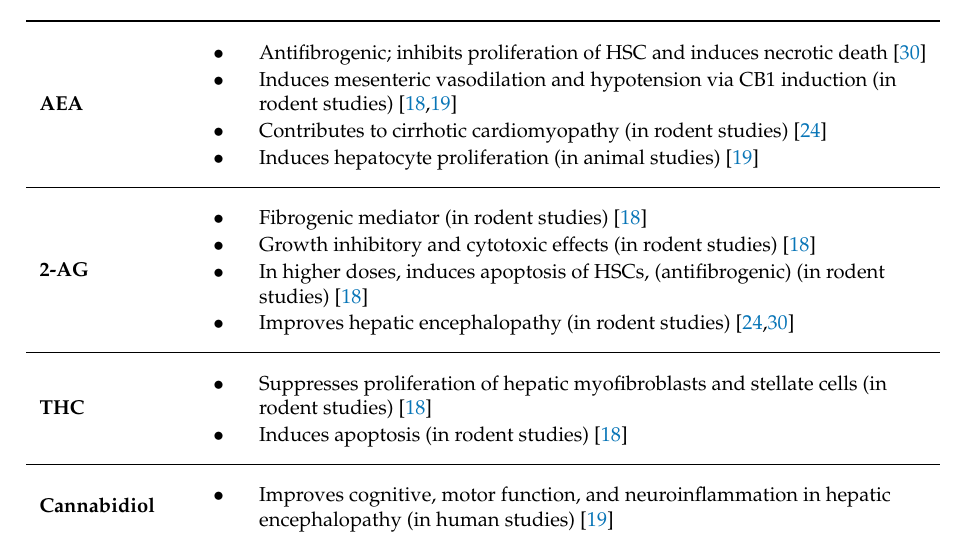
Table 2. Functions of Endocannabinoids and Exocannabinoids in